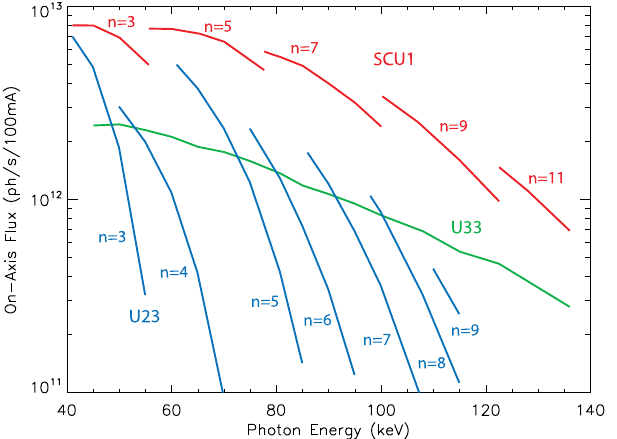
FIG. 19. Measured odd-harmonic SCU1 tuning curves (450 A maximum) of monochromatic flux through a 0 . 5 × 0 . 5 mm 2 aperture at 27.5 m compared with those of 11-mm minimum- gap permanent magnet devices U33 (continuous tuning curve envelope) and U23 (even and odd harmonics).